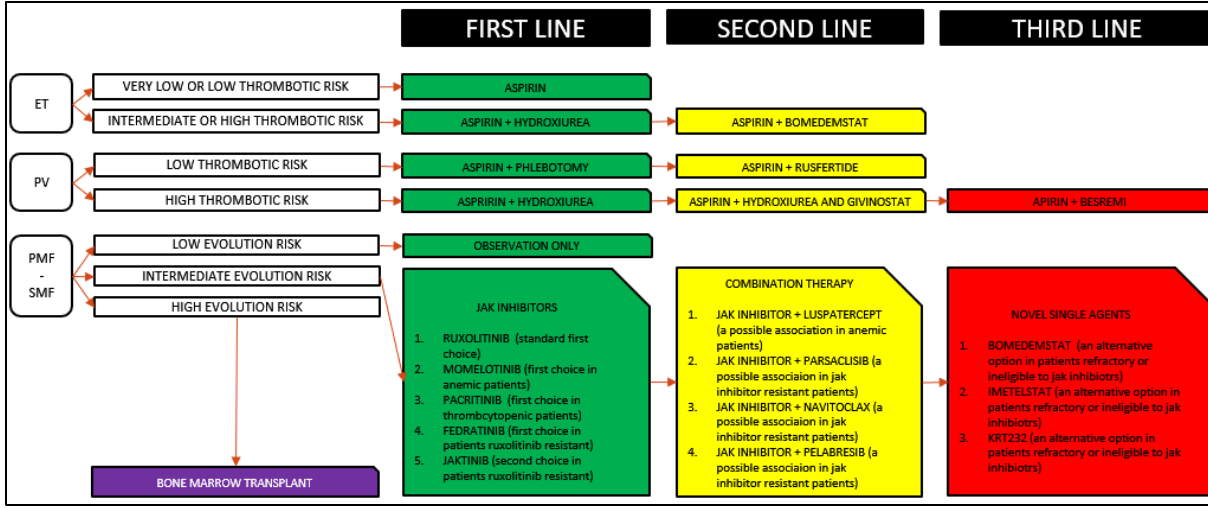
Figure 1. Reported at the end of the manuscript .